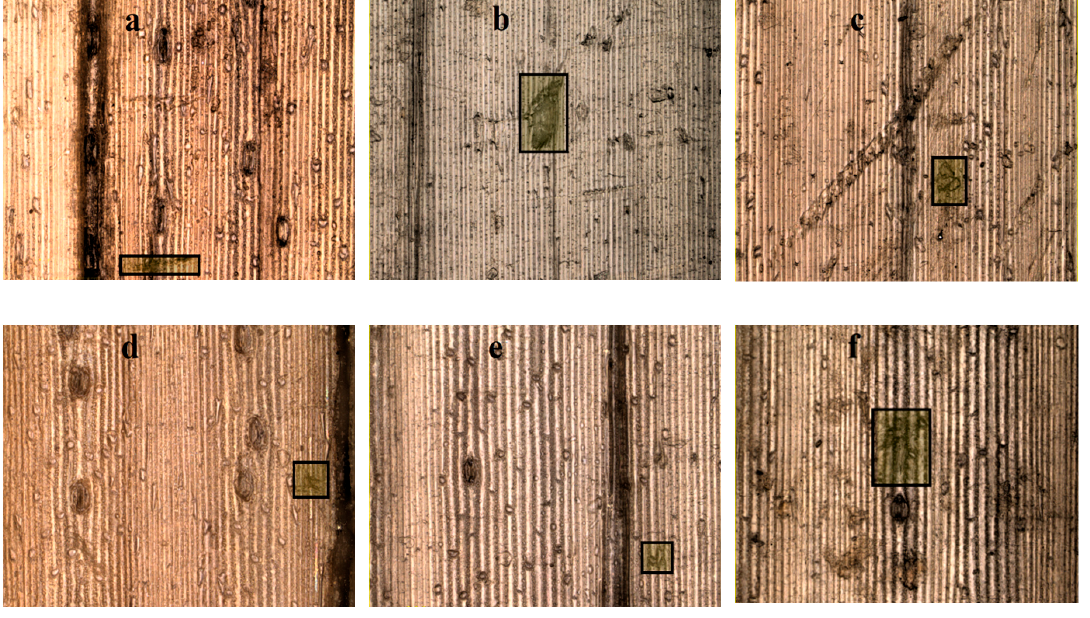
Figure 14. Measurement site of the wheat stalk over time with dry rotary tillage. Note: ( a – f )—2, 3, 4, 5, 6, 7 samplings with dry rotary tillage.